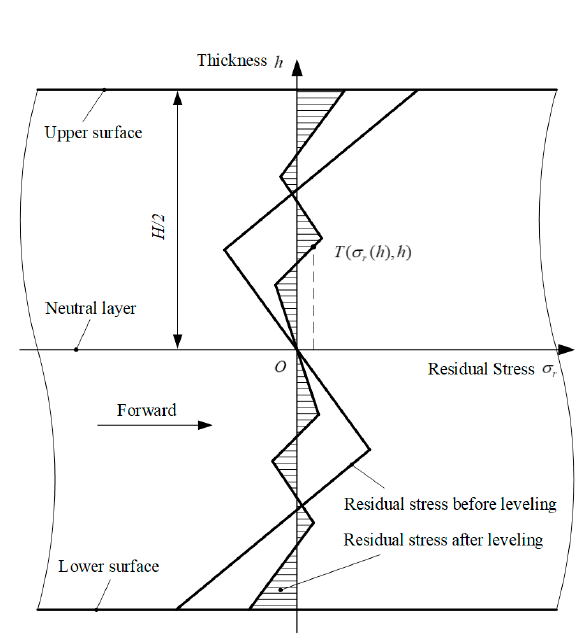
Figure 2. Distribution of the residual stresses before and after levelling.